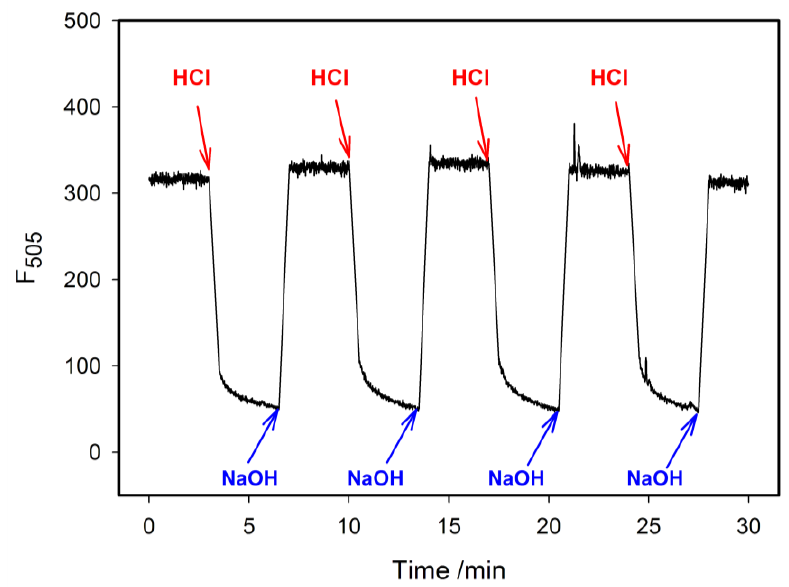
Figure 7. Reversible fluoresce response of 6tC probe to cyclic pH changes between 7.5 and 5.5. Fluorescence intensity was measured at 505 nm with λ ex = 395 nm at room